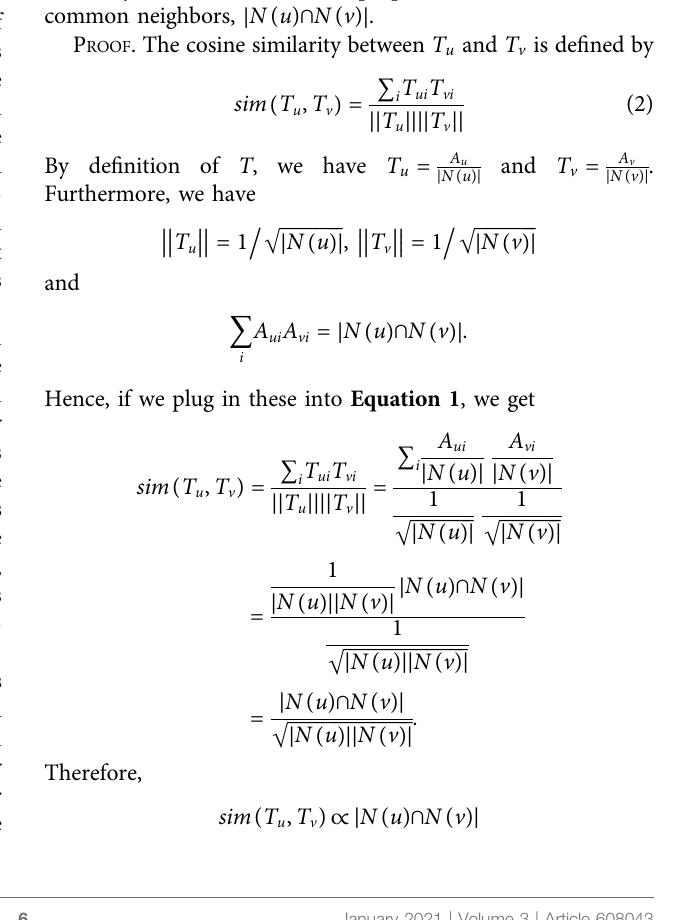
Frontiers in Big Data |